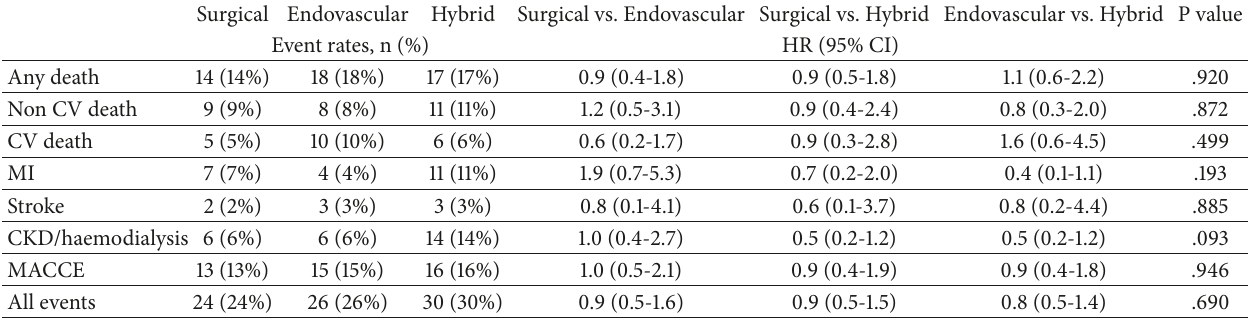
Table 6: Propensity-adjusted three-group comparison for the primary and secondary endpoints. Surgical Endovascular Hybrid Surgical vs. Endovascular Surgical vs. Hybrid Endovascular vs. Hybrid P value